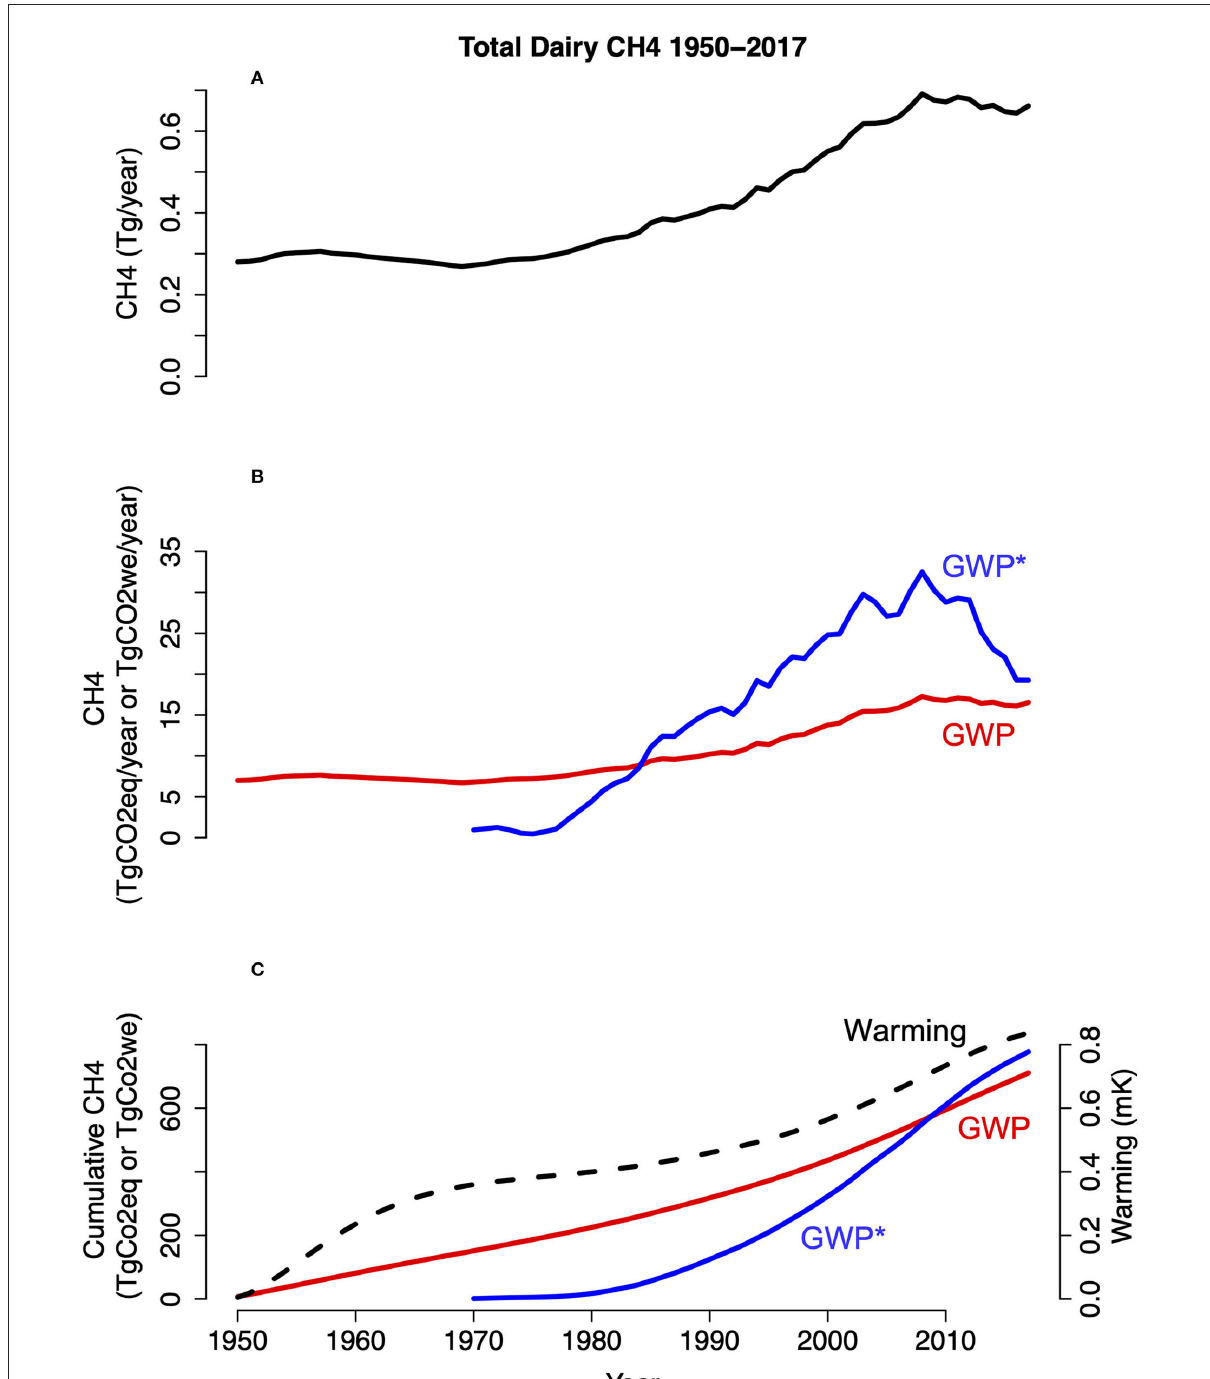
FIGURE2 California 1950–2017 total historical CH 4 emissions, comparison of these emissions converted to CO 2 eq and CO 2 we using GWP and GWP*, respectively, and cumulative CO 2 eq and CO 2 we with emissions-forced warming. The x -axis represents years and the y -axis represents annual CH 4 emissions (A) , annual CO 2 eq or CO 2 we (B) , or cumulative CO 2 eq or CO 2 we (C) . CO 2 we are represented in (B, C) by the blue solid line (“GWP*”), GWP-based CO 2 eq are represented by the red solid line (“GWP”), and temperature is given in (C) by the dashed black line (“Warming”). The temperature axis in (C) is scaled by 0.001 mK/TgCO 2 , or 1 K/TtCO 2 . The scaling factor that relates cumulative CO 2 emissions to temperature change is known as transient climate response to cumulative carbon emissions (TCRE). The scaling factor here (approximate TCRE) exceeds the IPCC likely range, likely due to a large increase in annual CH 4 emissions in the 1950s leading to a larger GWP of CH 4 in this period (see Section 4). This large GWP may be responsible for the “bulge” in warming between 1950 and 1990 (C)